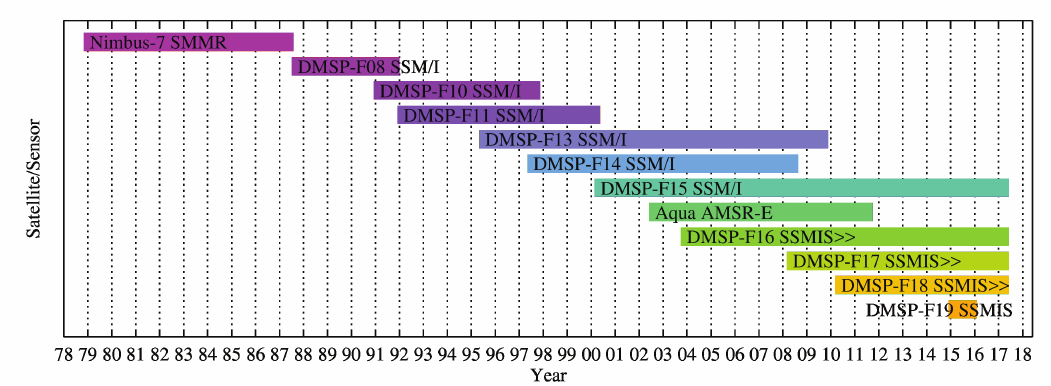
Figure 1. Calibrated, Enhanced-Resolution Brightness Temperature (CETB) passive-microwave sensor timelines, including periods with multiple sensor overlaps that have not been available in gridded form prior to CETB production. Making Earth System Data Records for Use in Research Environments (MEaSUREs) CETB data delivered to the National Snow and Ice Data Center (NSIDC) Distributed Active Archive Center (DAAC) as v1.3 include data through June 2017. Sensors labelled with “ >> ” are still operating in 2018. Beacon corruption on DMSP-F15 has rendered some F15 brightness temperatures